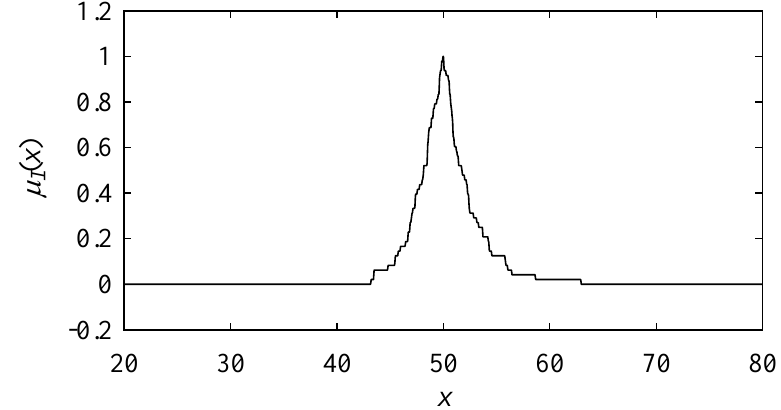
Figure A10. The nature of the possibility distribution of a unimodal point-cloud.